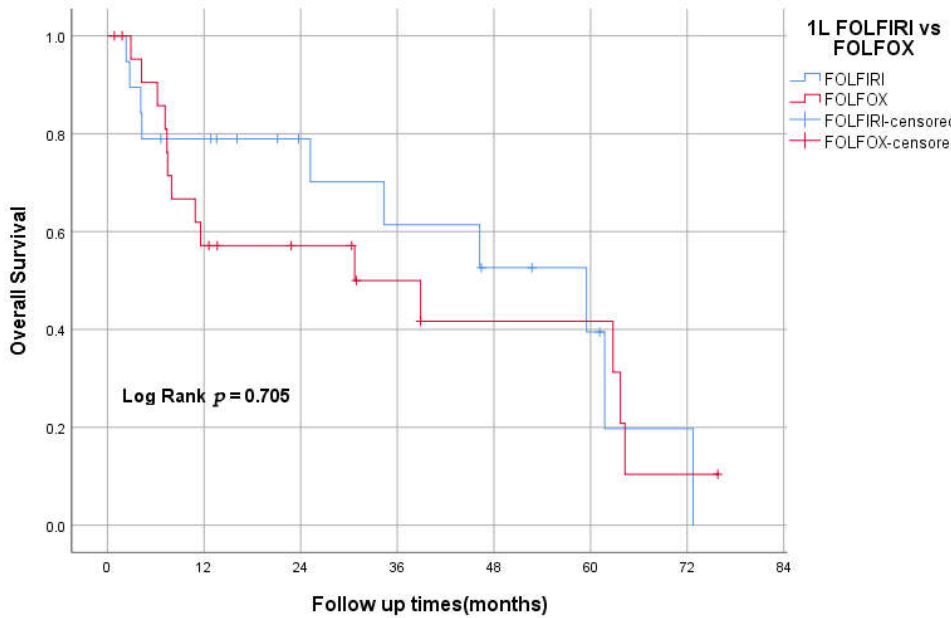
Figure 5. Kaplan–Meier curve of OS for first-line FOLFOX vs FOLFIRI.